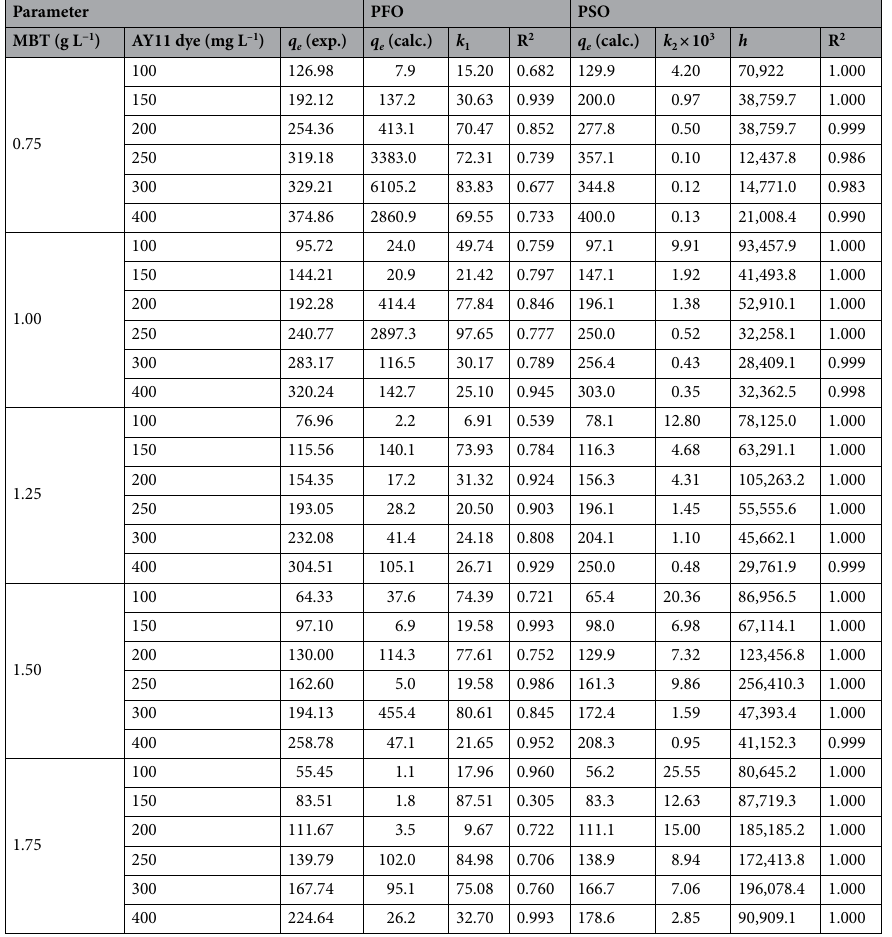
Table 3. The findings of the AY11 dye removal by MBT adsorbent using the PFO and the PSO